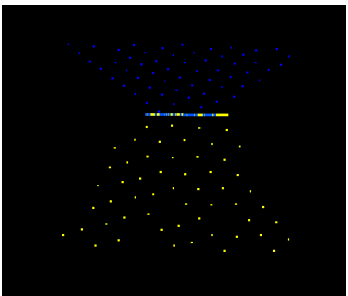
Figure 2 Extracted intersection line between Pr2 and Pr4, and the intersection parts of planar segments and the intersection